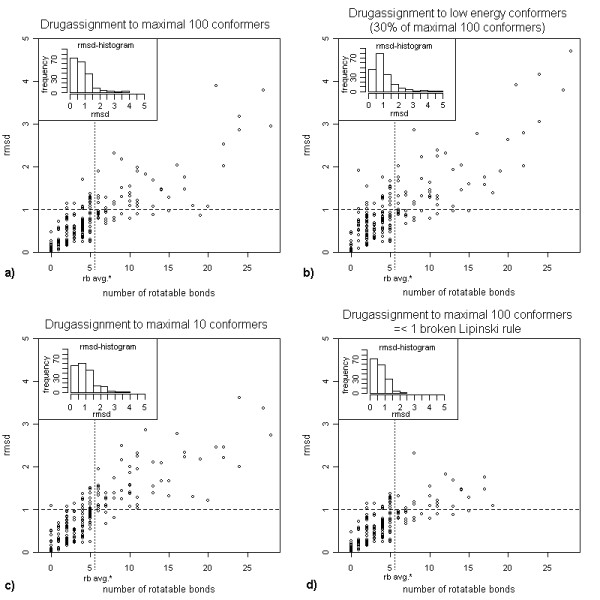
Drug-Ligand assignments. Each point represents one drug and indicates the average rmsd between bound instances and assigned unbound conformers. The vertical reference line (rb avg*) indicates the average number of rotatable bonds specified by Feher et al. [15]. a) Maximal 100 generated conformers per drugs were considered for drug ligand assignment. b) Drugs are assigned to low strain energy conformers. 30% of maximal 100 generated conformers were considered. c) Maximal 10 generated conformers per drugs were considered for drug ligand assignment. d) Maximal 100 generated conformers per drugs were considered and drugs violating Lipinski's "rule of five" were excluded.